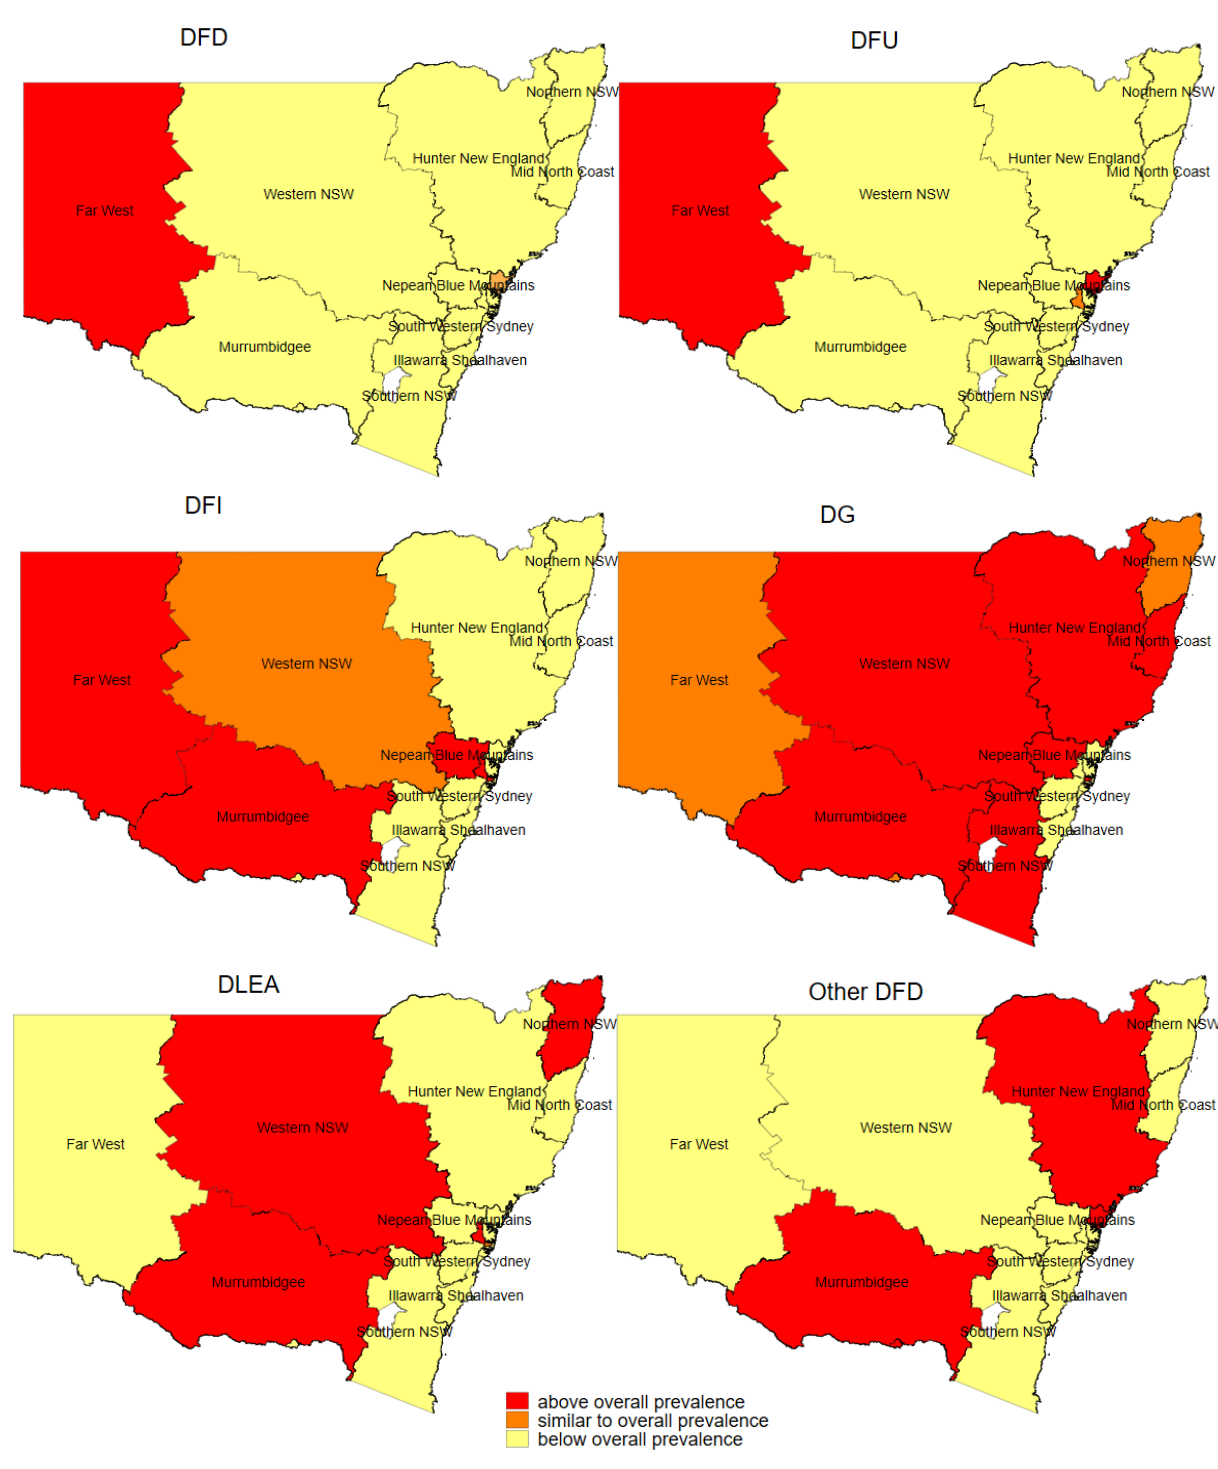
Figure 4. Age-standardised prevalence of diabetic foot complications in different local health districts (LHDs) of the state of New South Wales (NSW) among individuals aged 45 years and over during 2006–2012.